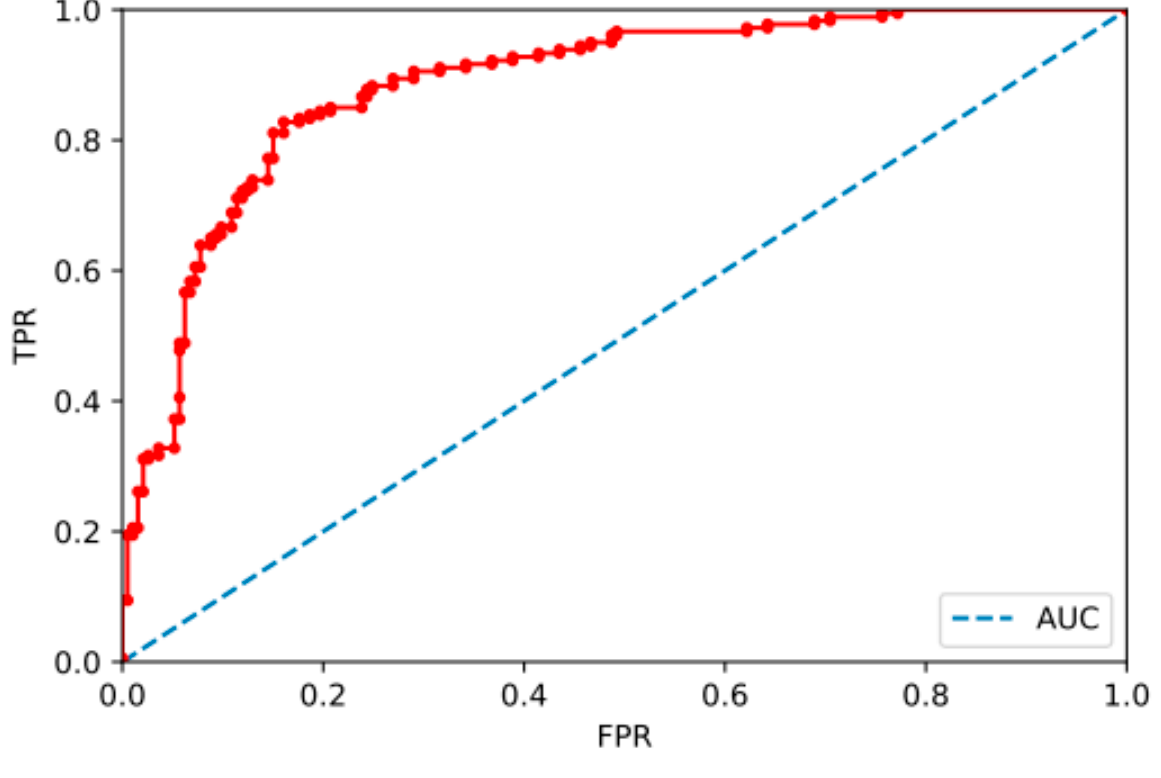
Figure 4. ROC curve of feedforward neural network model.